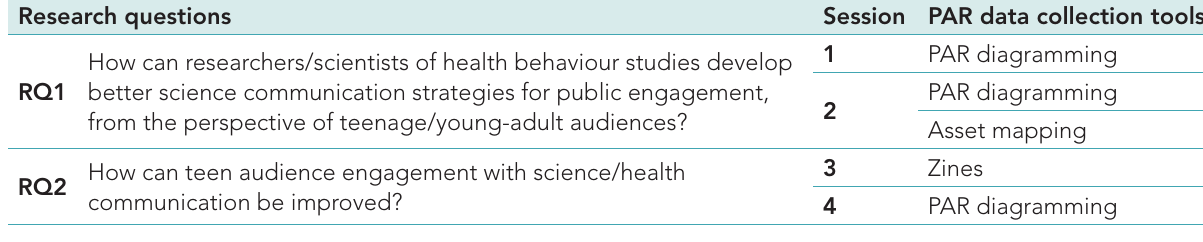
Table 1. Detail of data collection tools and co-design sessions (Source: Authors, 2022) Research